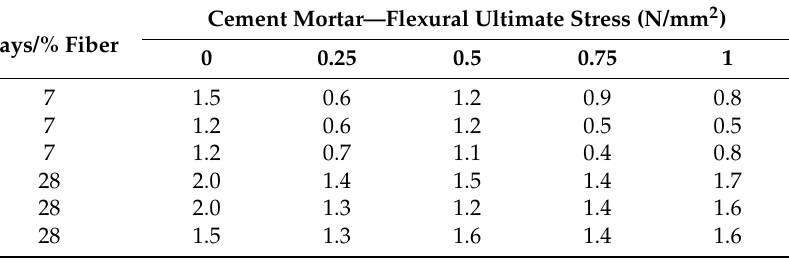
Table 5. Flexural tests for cement mortar.